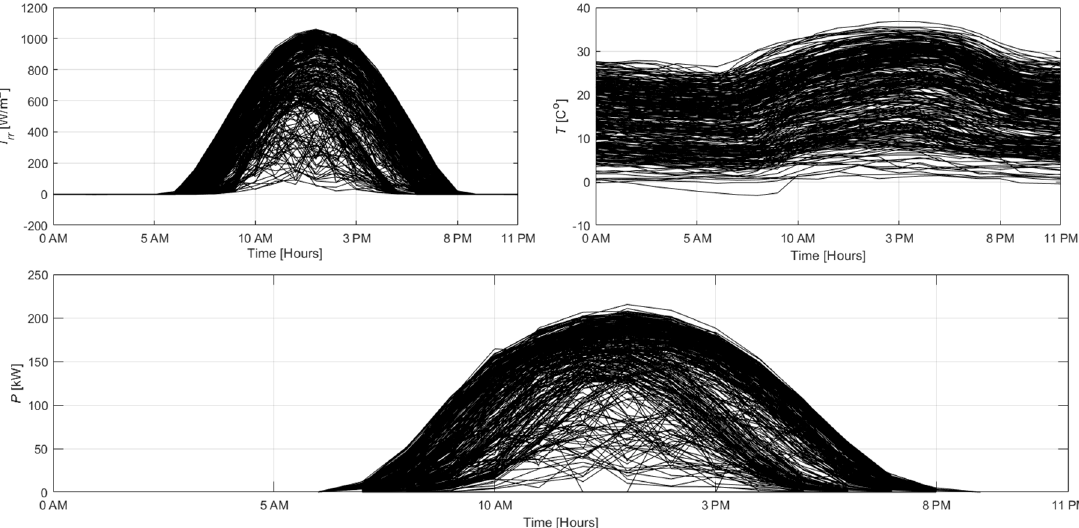
Figure 5. Hourly global solar radiations ( top left ), hourly ambient temperatures at 1 m altitude ( top right ) and corresponding solar power productions ( bottom ) in 2016.